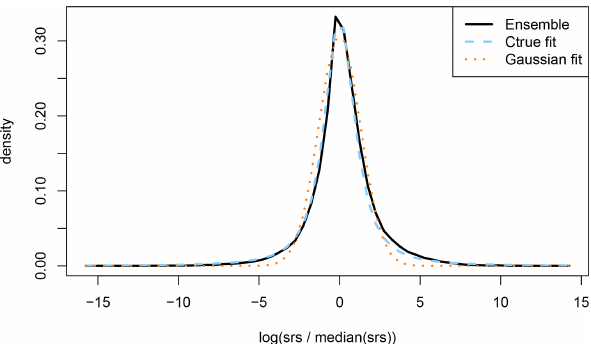
Figure 4. Probability density function showing how the atmo- spheric transport model ensemble members are distributed around the ensemble median (solid black line). Also shown are two fits, one using Eq. (5) (dashed blue line) and one using a Gaussian dis- tribution (dotted orange line). Note that the SRSs are scaled by its ensemble median and that the natural logarithm is